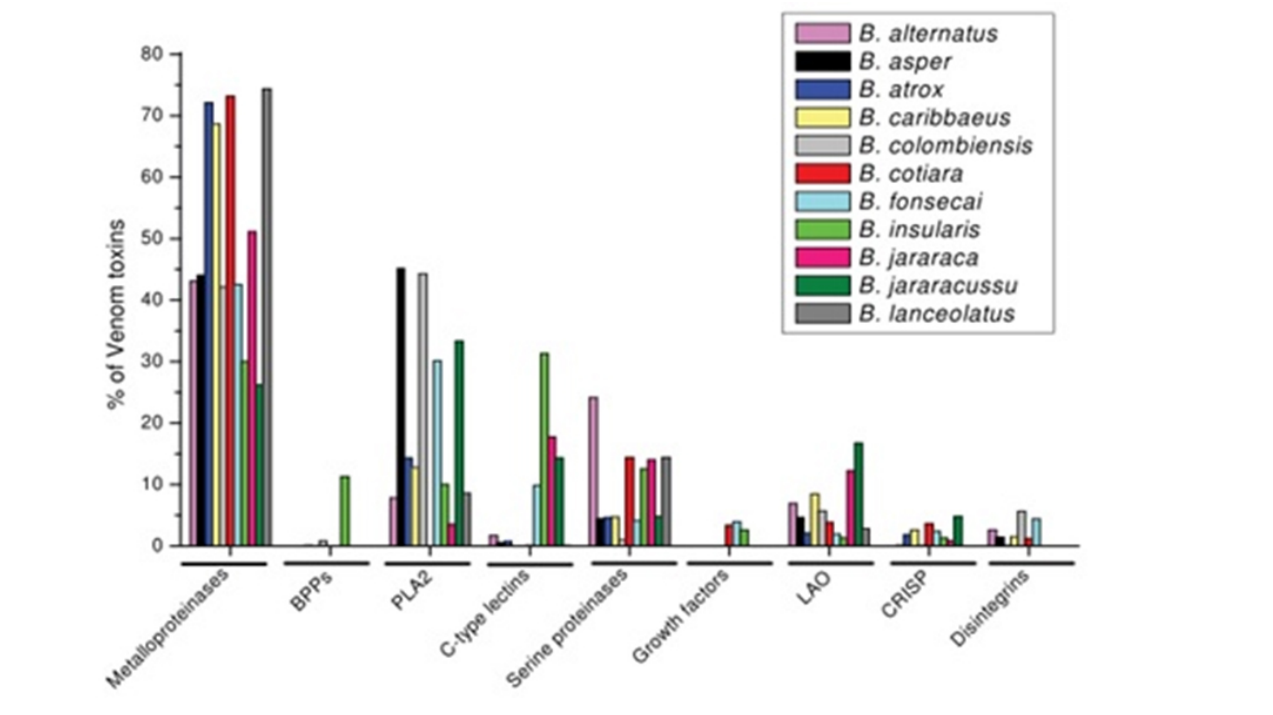
Figure 6. Relative abundance of the major toxin classes in bothropic venoms determined by proteomic analysis. Abundance expressed as a percentage of the total number of toxins identified in each analysis. BPPs: bradykinin-potentiating peptides; PLA venom cysteine-rich secretory proteins [39]. (Reprinted with permission from: Cardoso KC, et al. A transcriptomic analysis of gene expression in the venom gland of the snake Bothrops alternatus (urutu). BMC Genomics.